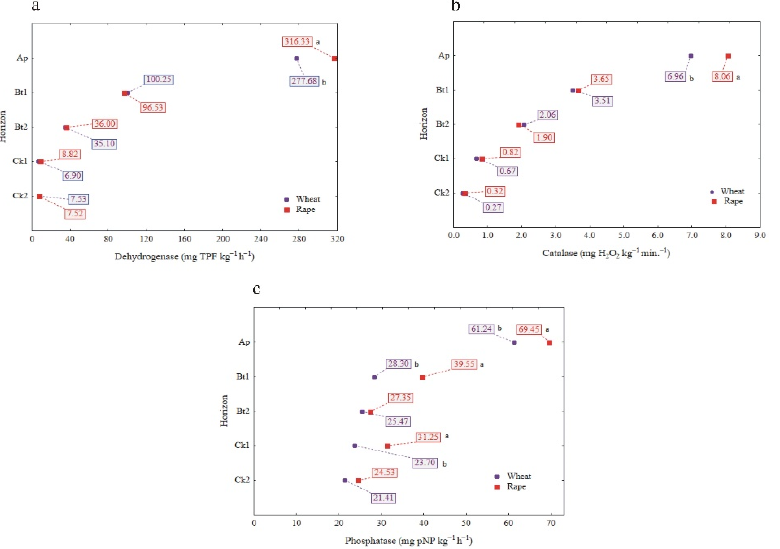
Figure 4. The influence of cultivated plants (winter wheat and winter rape) on enzyme activity: DHA( a ), CAT ( b ) and PHA ( c ). Different lowercase letters indicate significant differences ( p < 0.05) between cultivated plants in the same genetic horizons of profiles (mean values for the study sites).